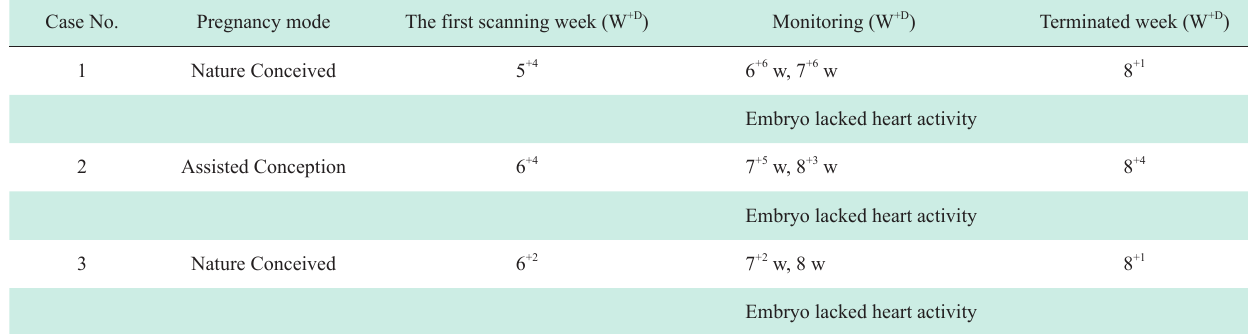
Table 1 The 3 cases of angular pregnancy with embryos demise Case